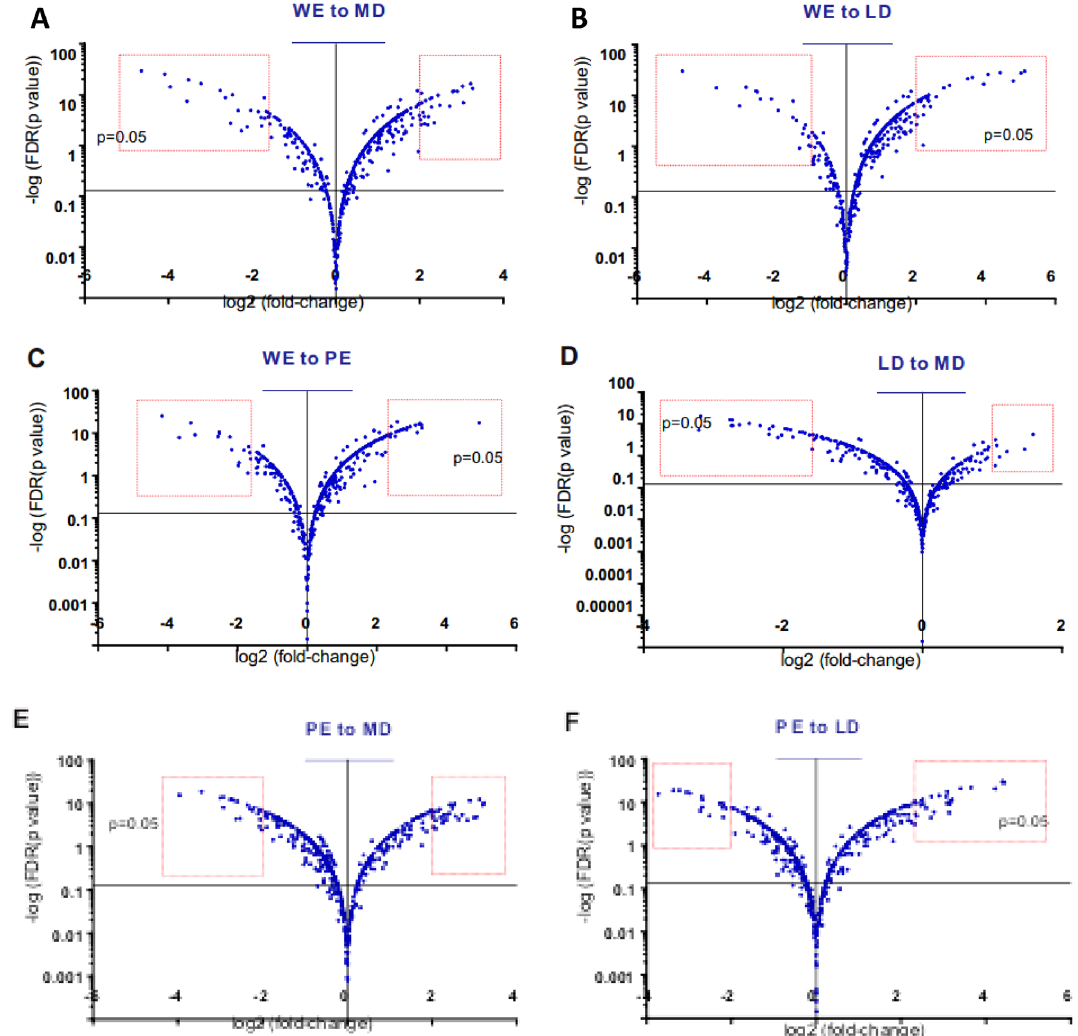
emmer; LD—landraces durum; MD—modern durum. All the metabolites that are above the horizontal line of p < 0.05 were considered significant. Red rectangles insets—the most significantly changed metabolites are shown in Tables S1 and